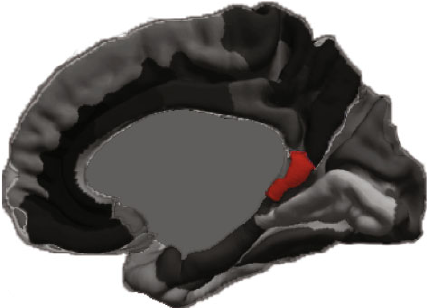
Figure 2: Increased volume of right ventral PCC/ISC. Display of increased volume of ventral PCC/ISC following